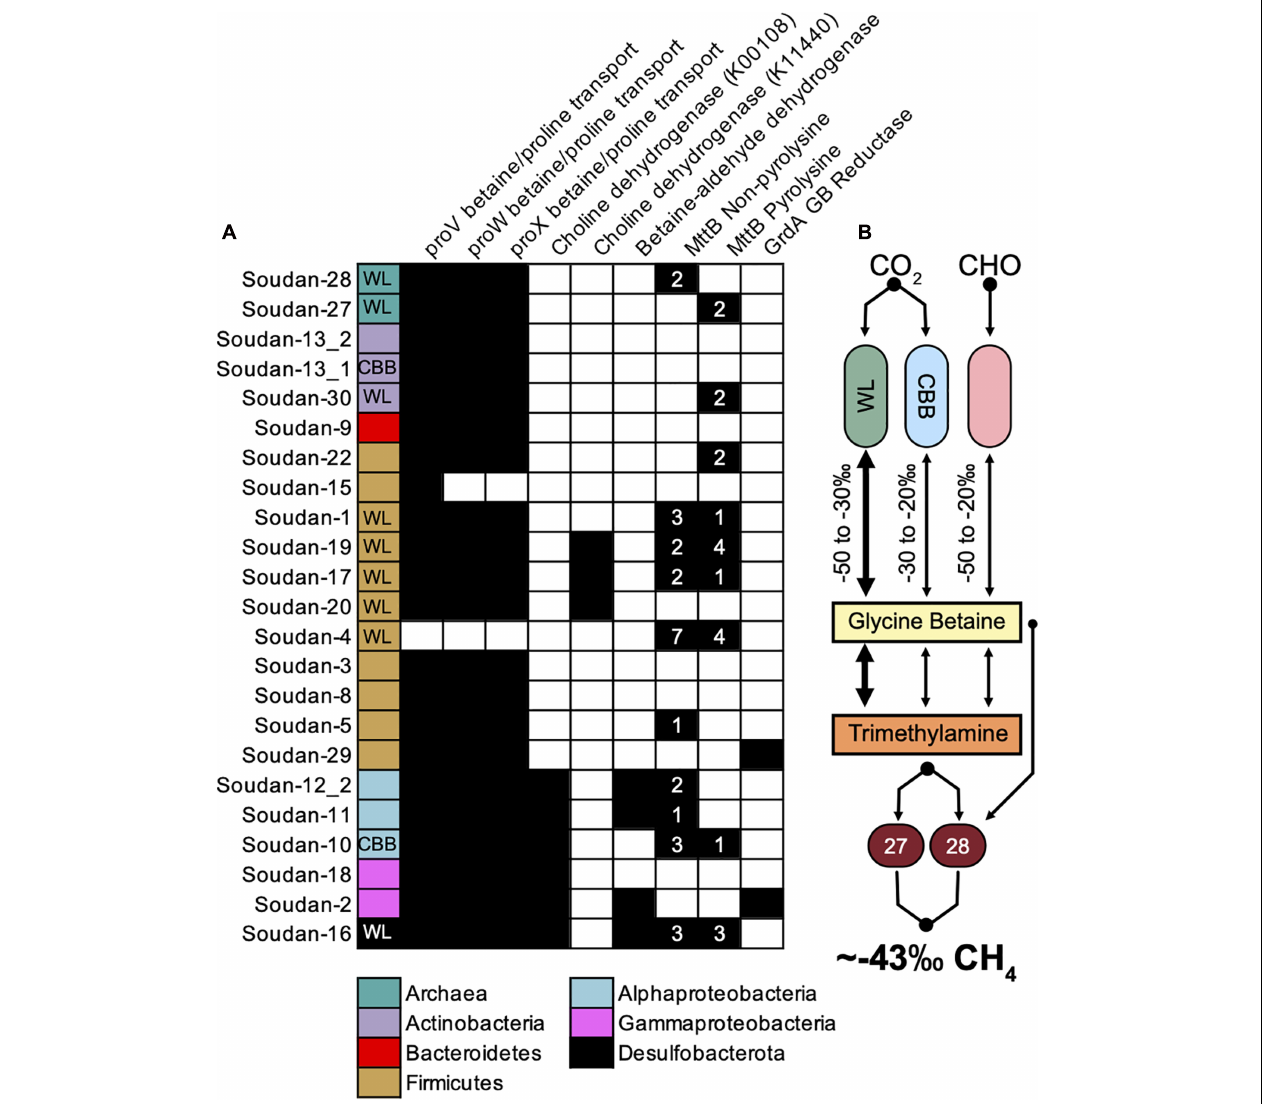
FIGURE 4 | Potential routes for Trimethylamine (TMA) production and isotopic fractionation of methane. (A) MAGs containing genes for glycine betaine uptake, glycine betaine production, and glycine betaine conversion to trimethylamine (left to right). Colored boxes represent phyla association and WL and CBB inset indicate the presence of the Wood-Ljungdahl or Calvin-Benson-Bassham cycle. (B) Theoretical flow of carbon and the potential isotopic fractionations that would render the methane signature of